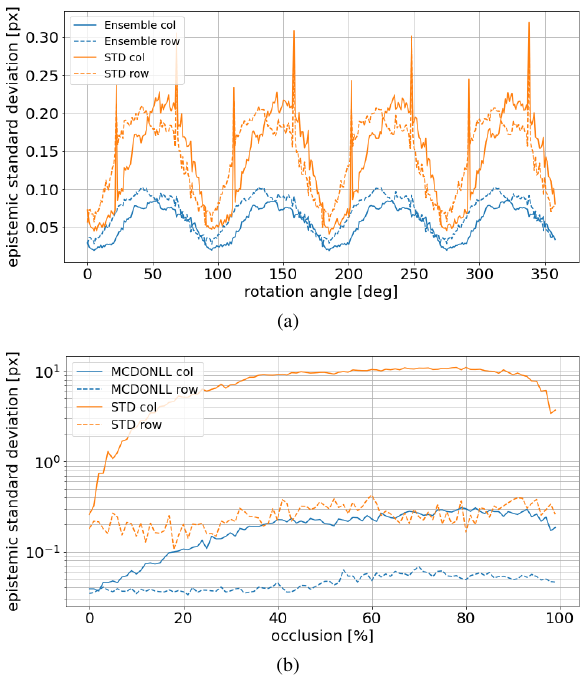
Figure 8. Epistemic standard deviation estimates and STD in image columns and rows in pixel units with (a) Ensemble on the rotation dataset and (b) MCDONLL on the occlusion